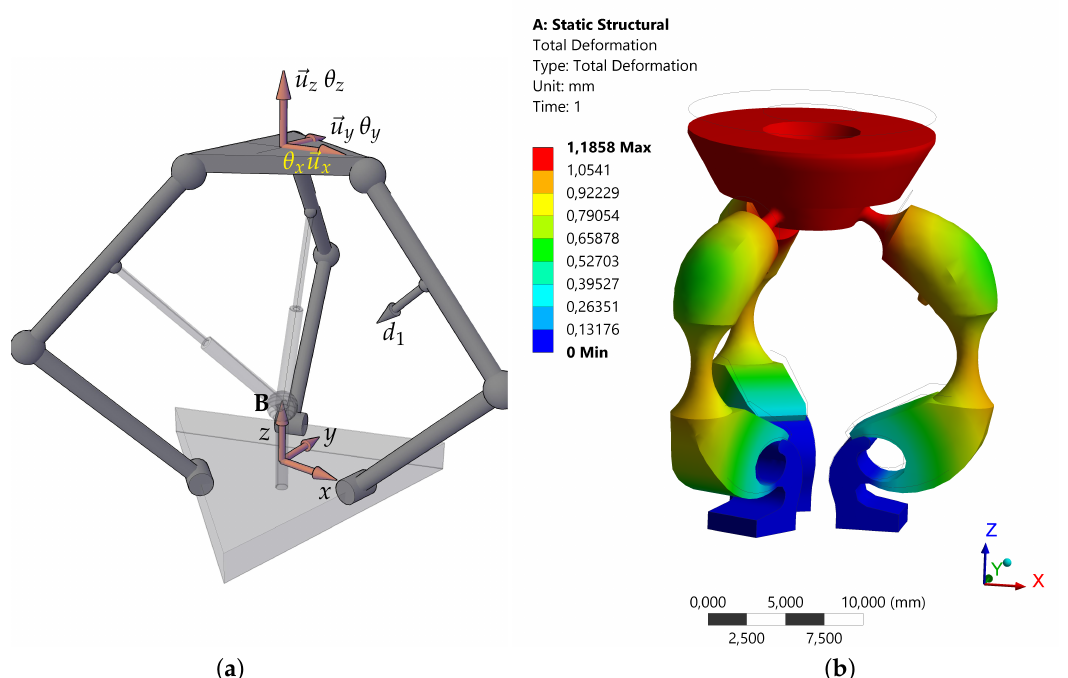
Figure 5. ( a ) Reference frames and nomenclature; ( b ) platform displacement along the z -axis, negative direction (Case